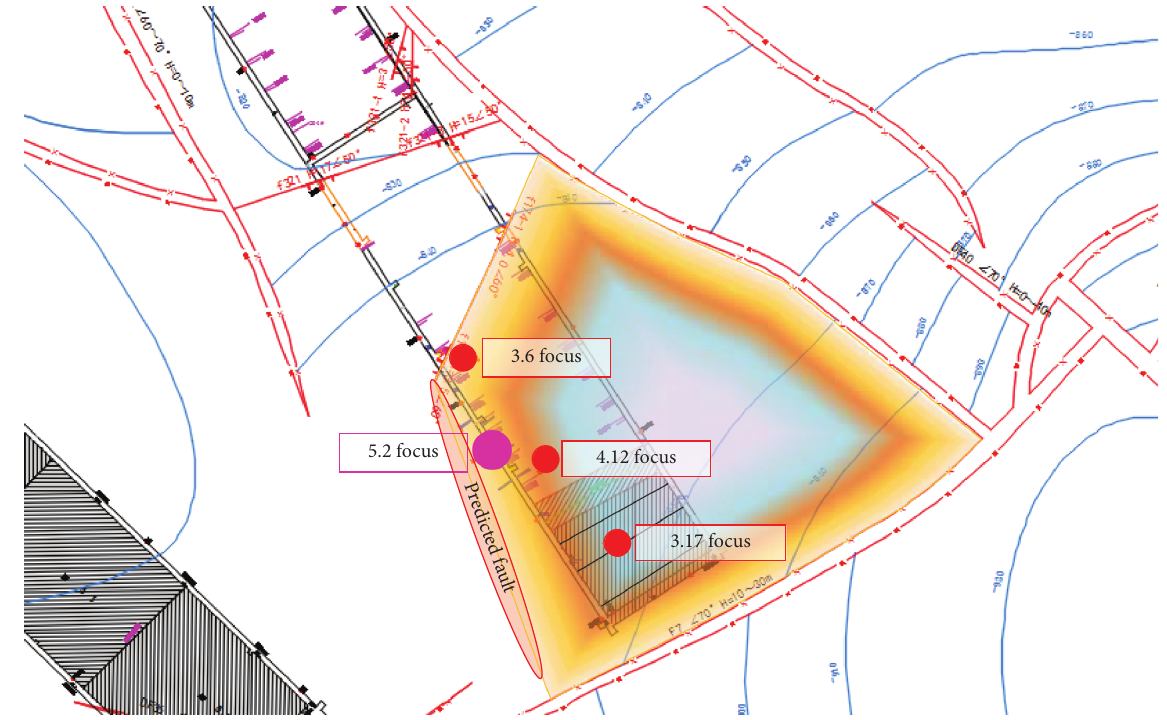
Figure 15: Schematic diagram of regional tectonic influence.